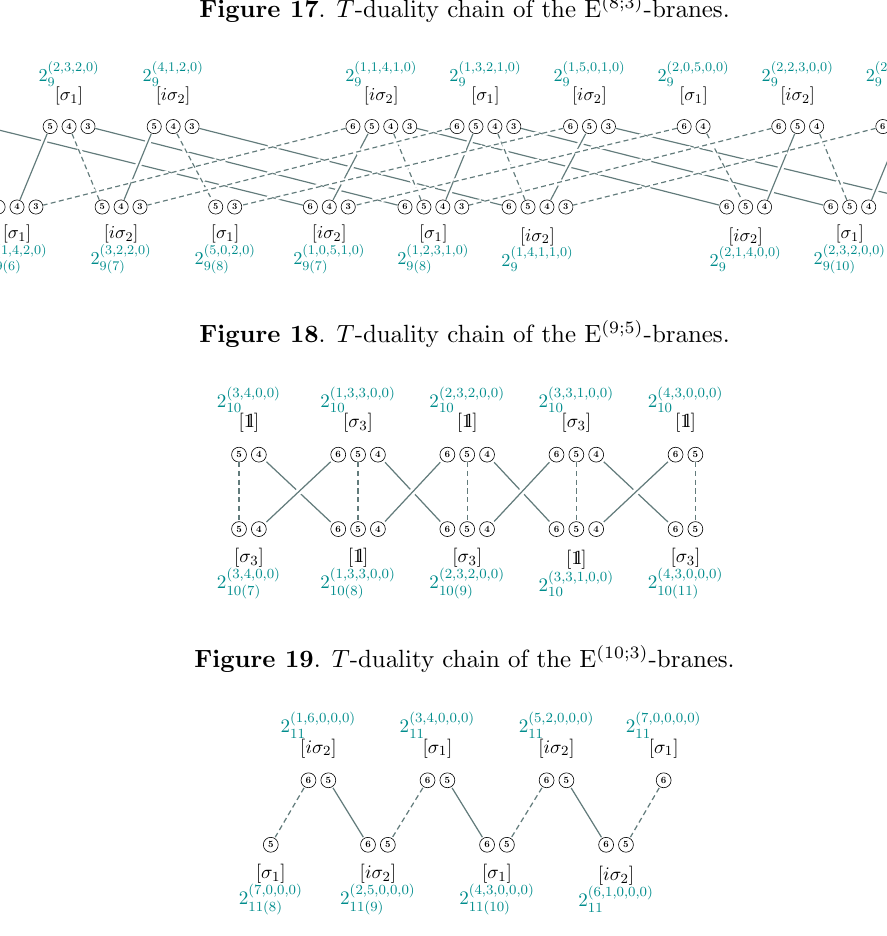
Figure 20 . T -duality chain of the E (11;7)